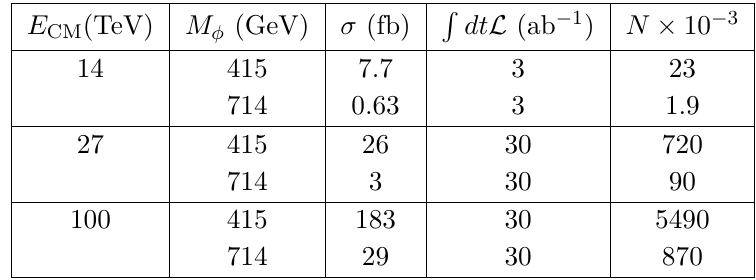
Table 2 . Comparison of the LHC, HE-LHC and 100 TeV pp sensitivities to (cid:30) + (cid:30) 0 electroweak Drell-Yan production for representative choices of M (cid:30) . Note that K -factors have not been applied, as discussed in the text.